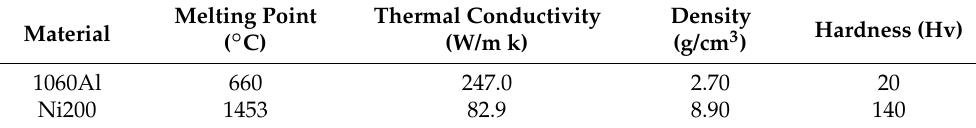
Table 2. Physical properties of two welding materials. Material